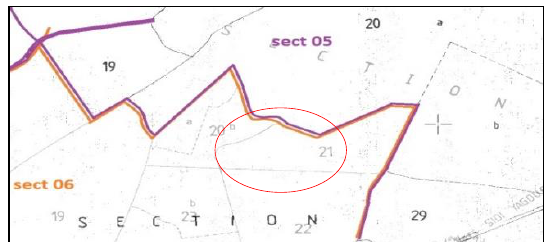
Figure 1. The first form of overlapping problem.